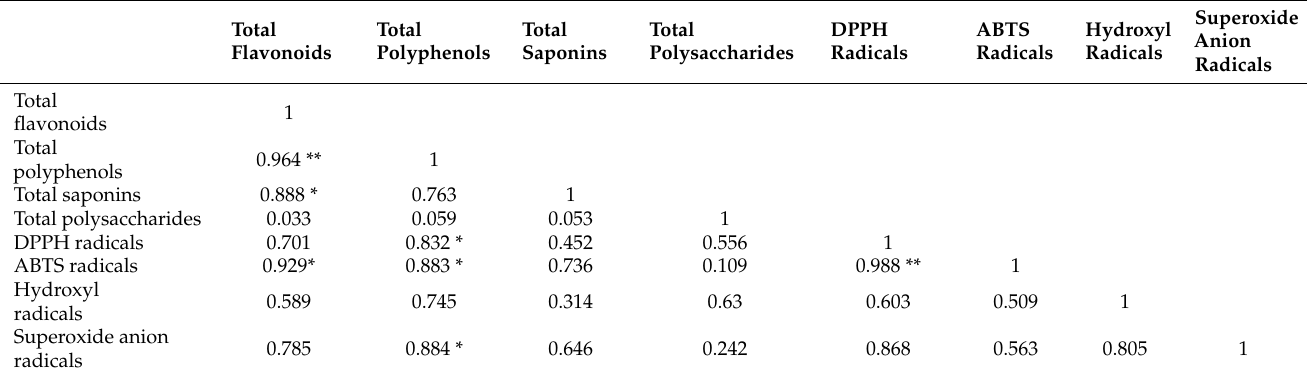
Table 4. Correlation analysis of the antioxidant activity and active